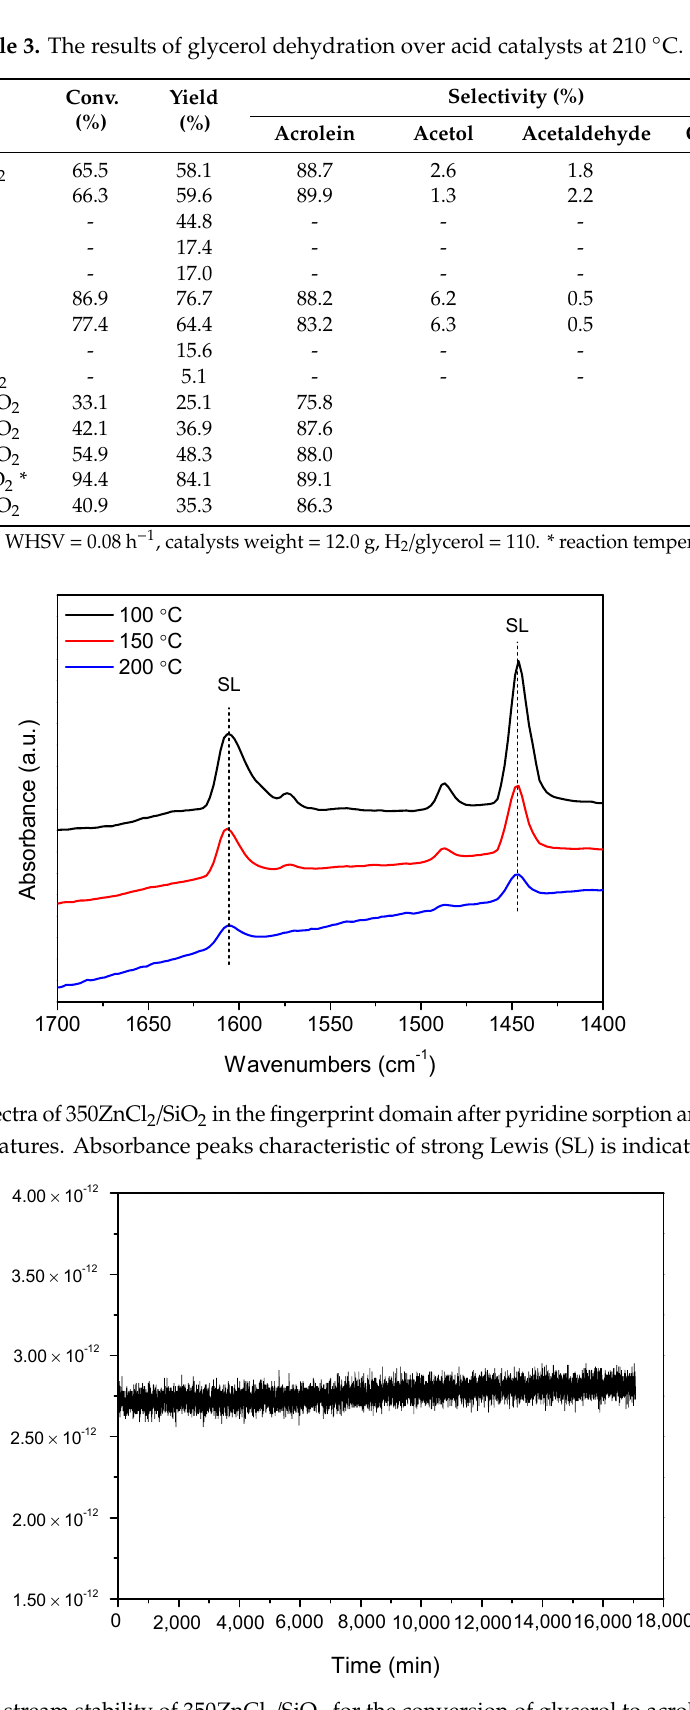
Figure 8. Time on stream stability of 350ZnCl 2 /SiO 2 for the conversion of glycerol to acrolein at 230 °C.